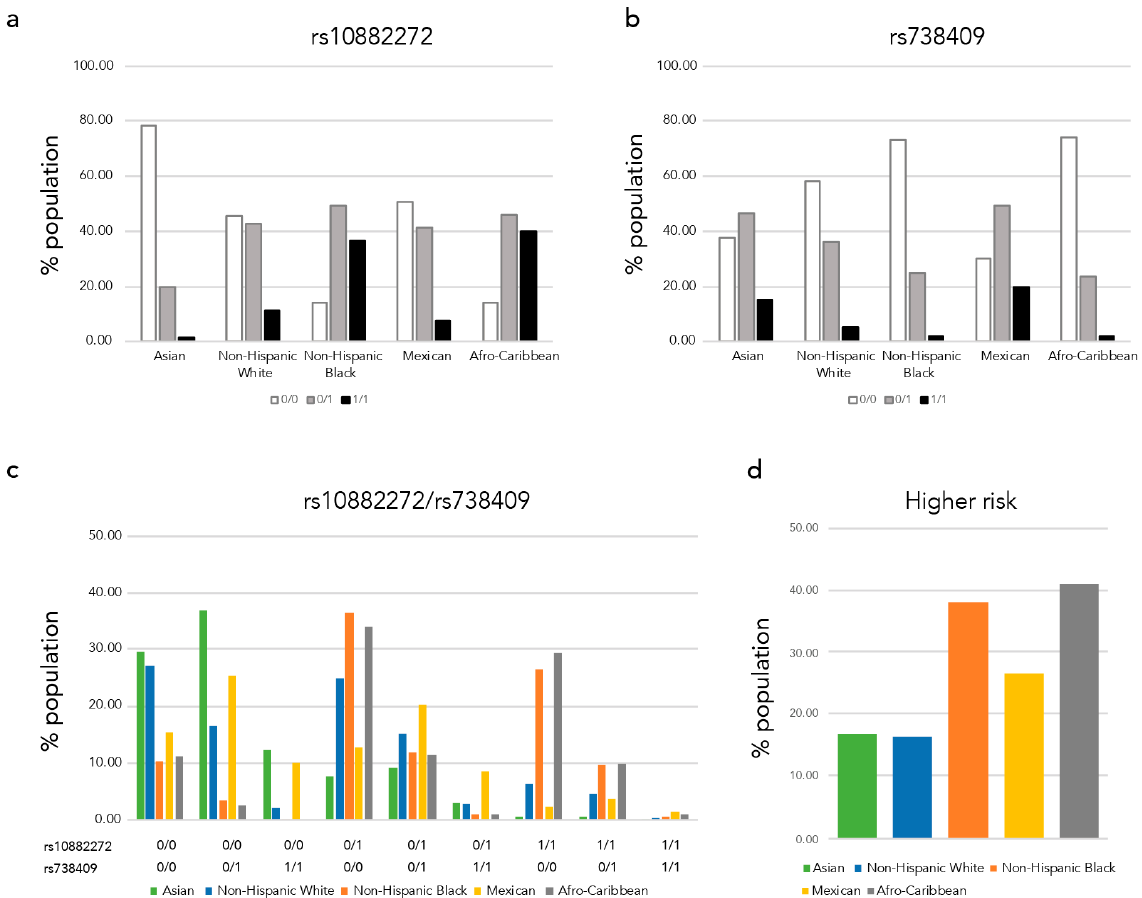
Figure 2. Low-serum retinol risk allele proportions of each race/ethnic group. We plotted the low-serum retinol risk allele proportion of each ethnic group ( a ) rs1088272, ( b ) rs738409, ( c ) rs1088272 and rs738409 variant combinations, and ( d ) proportion of higher risk